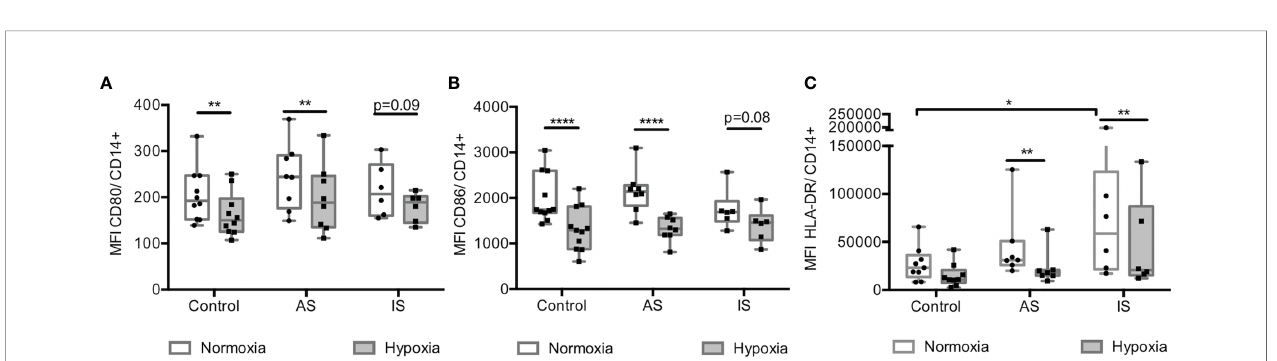
FIGURE 3 | Hypoxia decreased CD80 and CD86 co-stimulation molecules and HLA-DR. (A – C) Effect of hypoxia on CD80, CD86 and HLA-DR surface expression on CD14+ MD-macrophages from controls, high active sarcoidosis (AS), and low active or inactive sarcoidosis (IS). Results are expressed as the mean fl uorescence intensity (MFI) of CD80 (A) , CD86 (B) and HLA-DR (C) analyzed by fl ow cytometry. Results are expressed as box plot showing 25 th and 75 th percentile and median, each point indicates a patient and/or control (n = 6-11/group). *p < 0.05; **p < 0.01; ****p < 0.0001 in two-way ANOVA-repeated measures with Sidak post-hoc test.